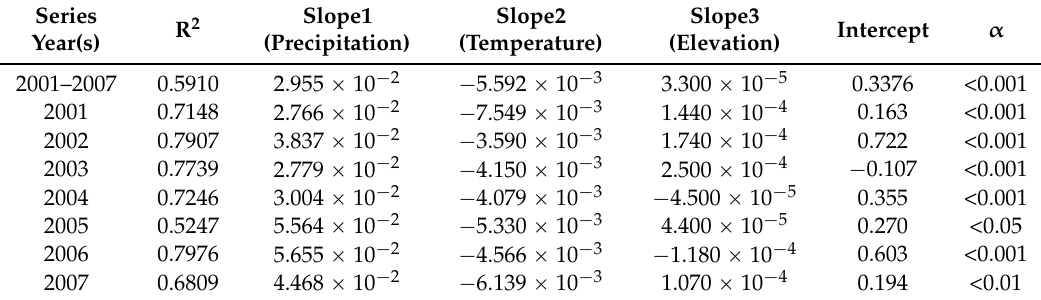
Table 3. Average coefficients of determination, slope, and intercept terms for each model across entire study